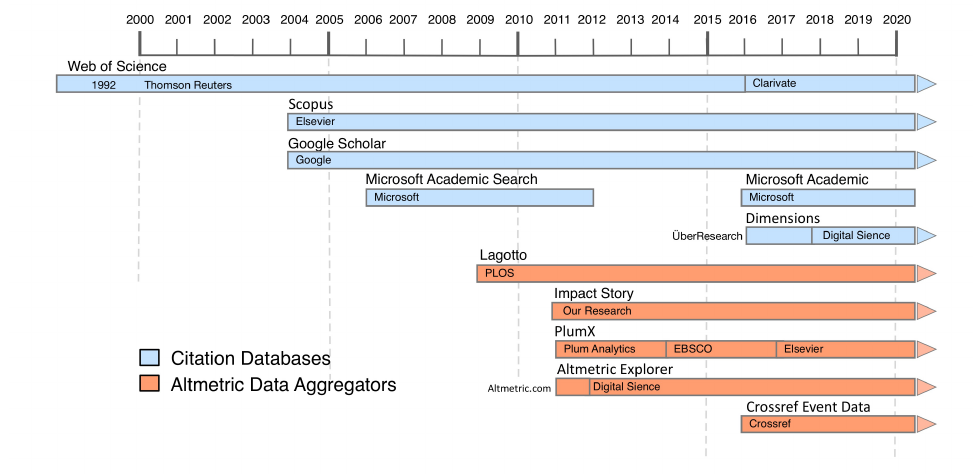
Figure 1. Development of citation databases and altmetric data aggregators. Source: Authors’ own